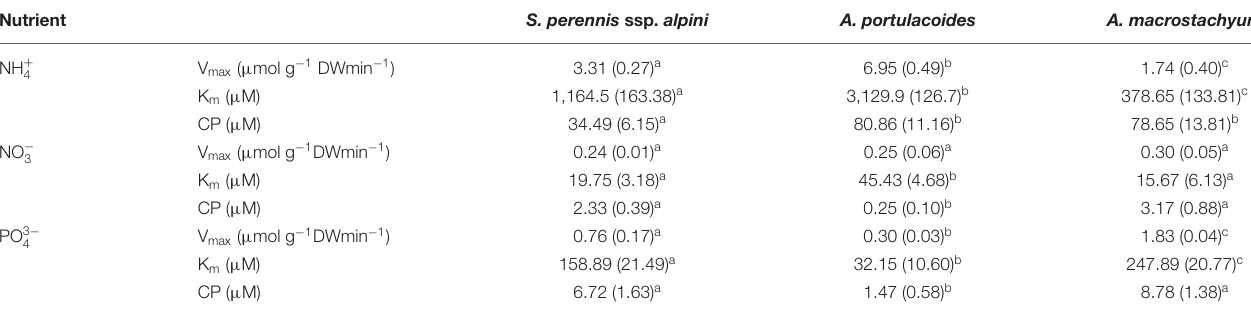
TABLE 1 | Kinetic parameters of ammonium, nitrate, and phosphate uptake curves in the three species considered in this study. Nutrient